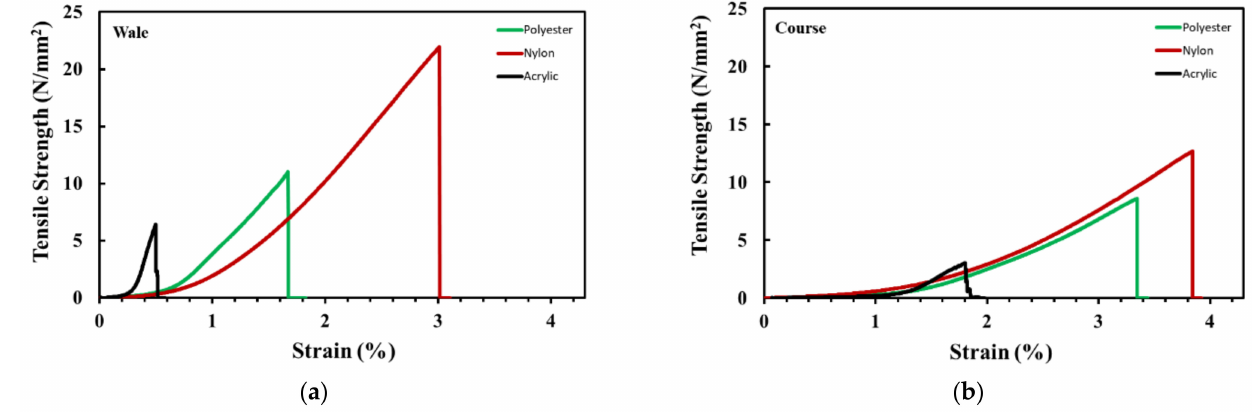
Figure 9. The tensile strength and the strain according to fabric direction. ( a ) Wale. ( b )